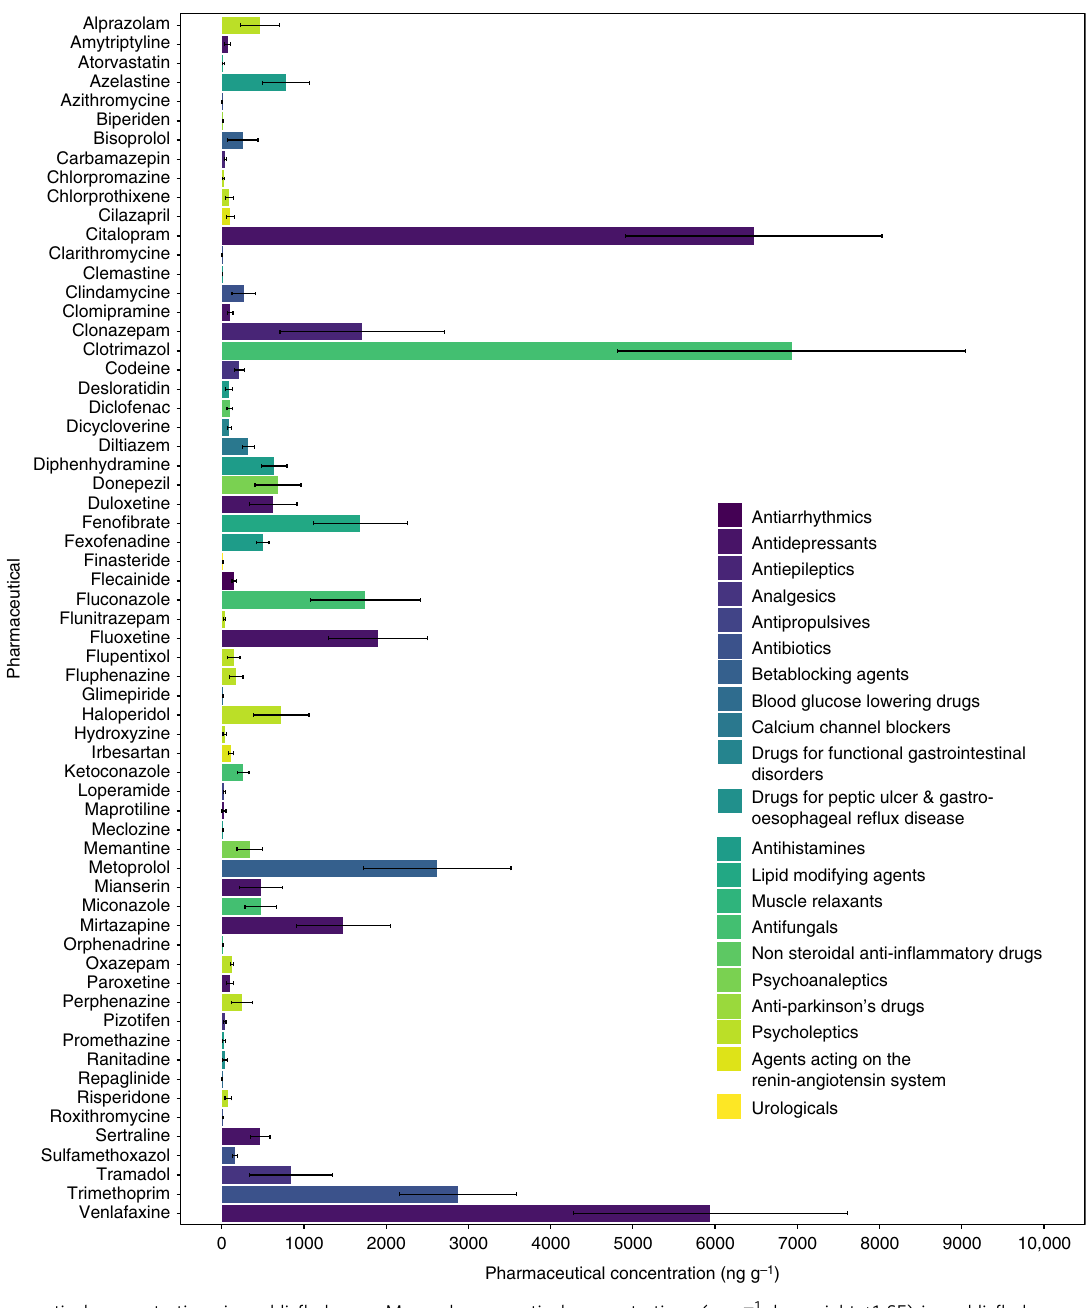
Fig. 1 Pharmaceutical concentrations in caddis fl y larvae. Mean pharmaceutical concentrations (ng g − 1 dry weight ±1 SE) in caddis fl y larvae (Hydropsychidae) ( n = 6) at wastewater-in fl uenced Brushy Creek. Each bar represents the mean concentration of a pharmaceutical compound in the six individuals collected over two sampling dates. Colours represent therapeutic drug